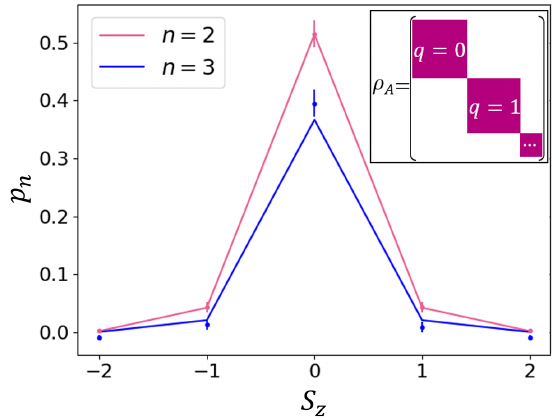
FIG. 6. Symmetry-resolved RDM moments of the XX model ground state with N A = 20 and n = 2, 3. The lines are the exact values and the dots are the extracted values using the partial-basis distribution, Eq. (29), with the errors estimated from the sam- ple variance. The number of samples M used is approximately , where ξ 3 = 1.65. Inset: when the RDM commutes with 10 2 ξ N A 3 ˆ the charge operator Q A , it decomposes into blocks corresponding to different charges in subsystem A